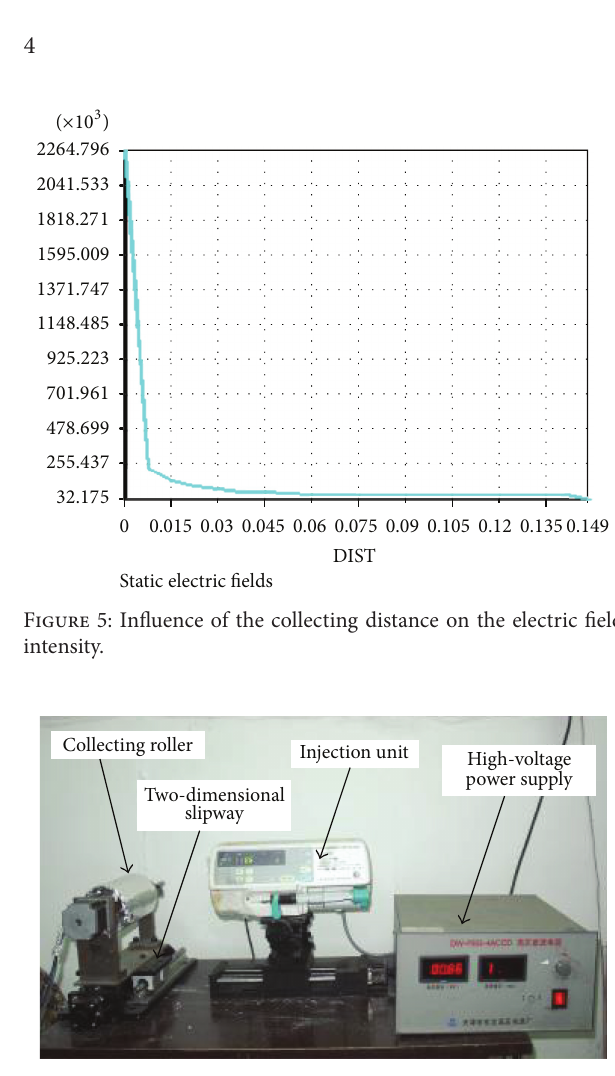
Figure 6: Electrospinning experimental